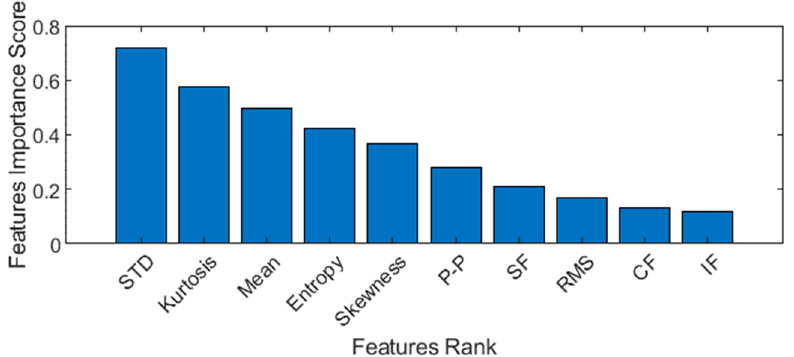
Figure 5. Features importance score to select most relevant features